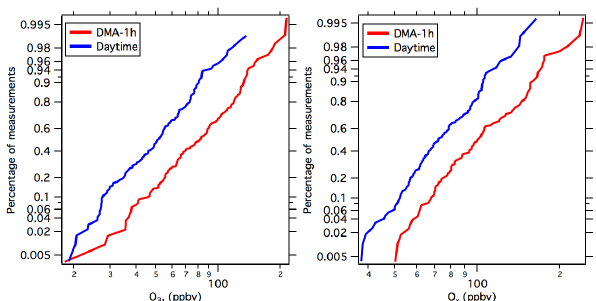
Figure 3. Logarithmic plots of probability vs. measurement values in terms of ambient O 3 (left) and O x (right) in 1h daily maximum averages (red) and 12h daytime averages (blue), respectively, in Beijing, August between 2005 and 2011.